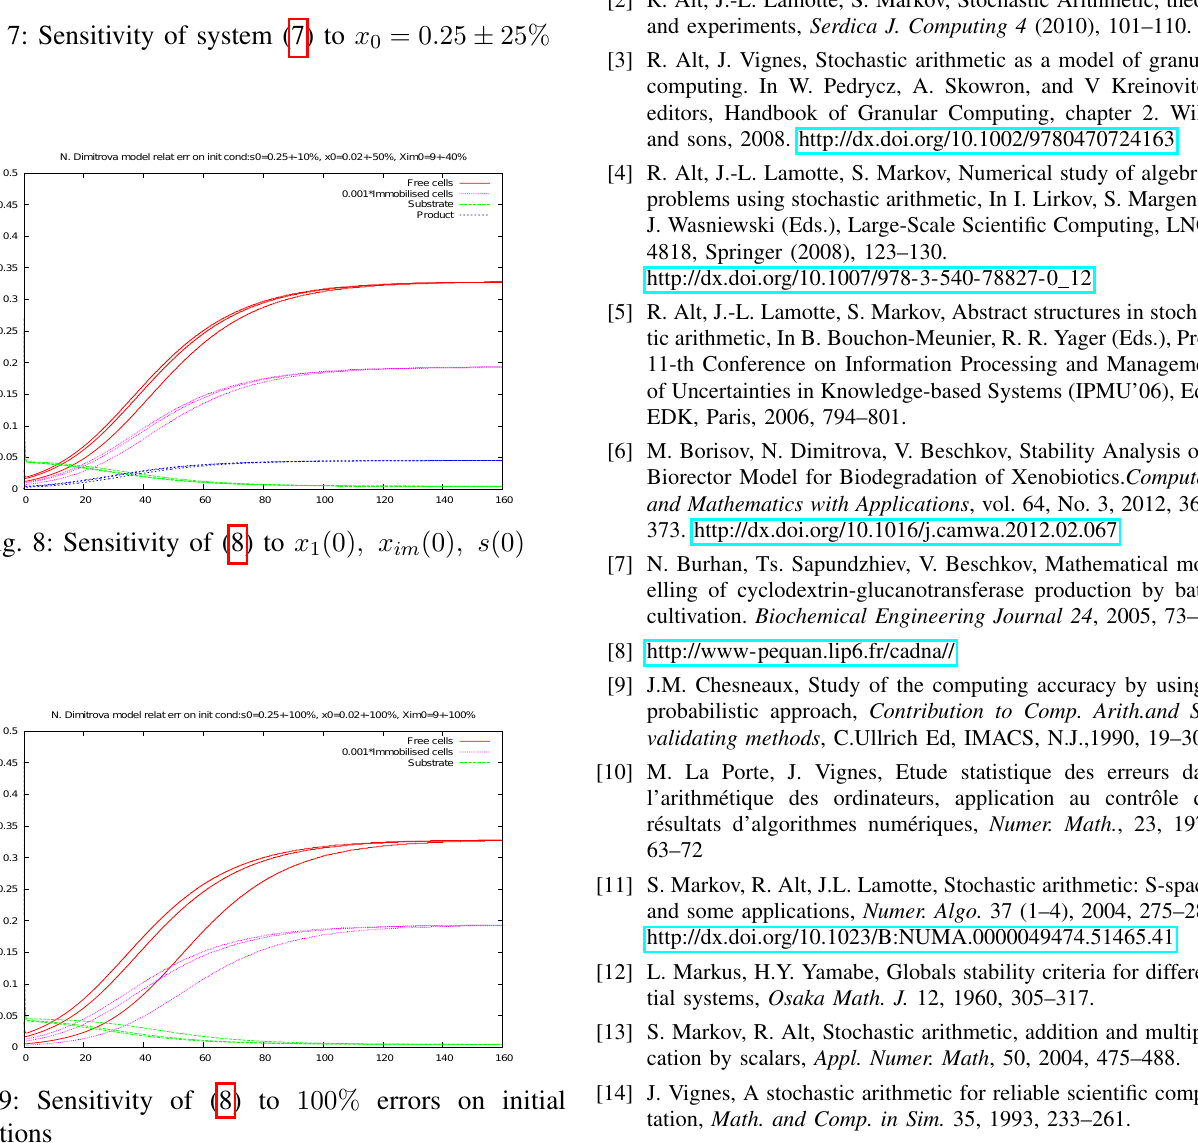
Fig. 7: Sensitivity of system (7) to x 0 = 0 . 25 ± 25%